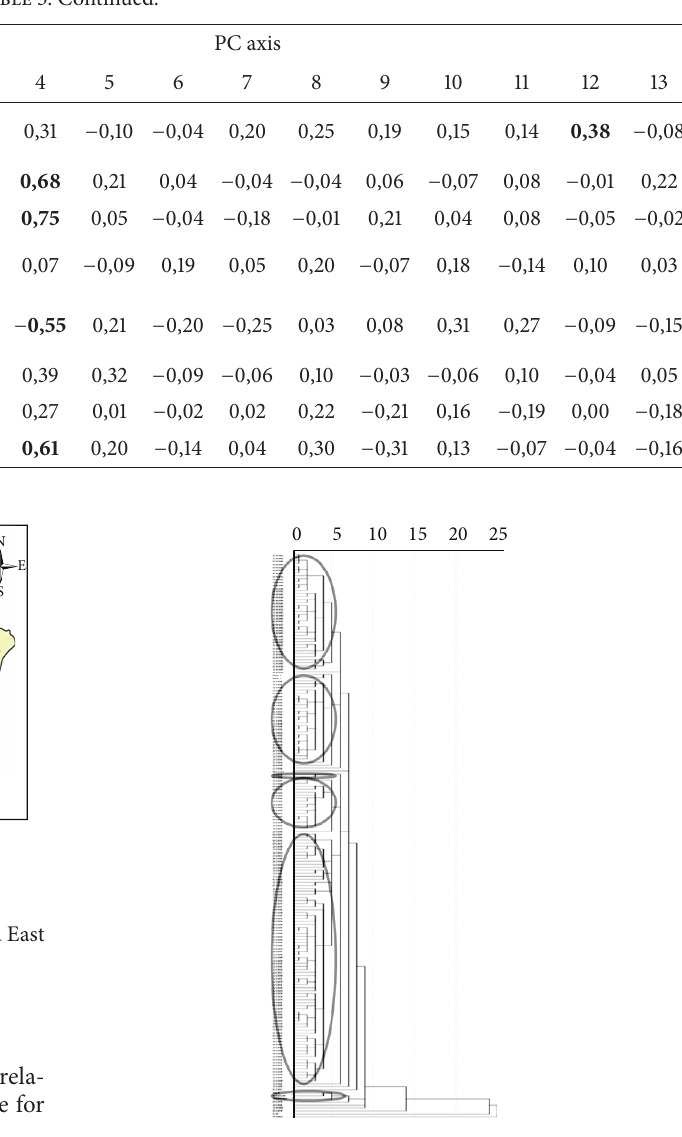
Figure 2: Cluster analysis for 188 genotypes/clonal rootstocks based on morphological data.